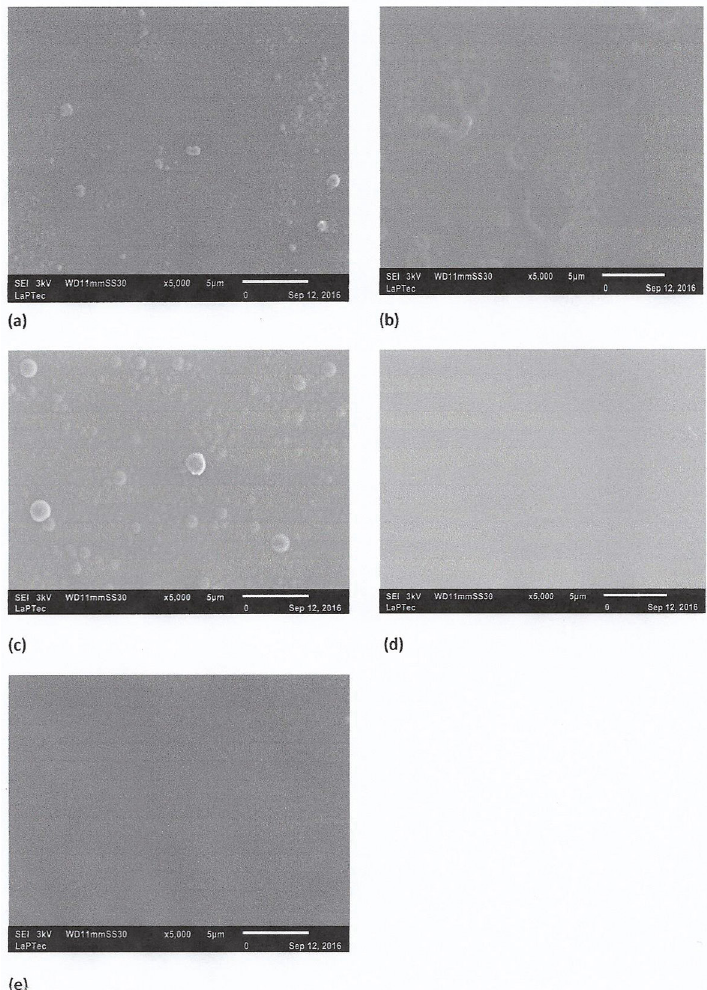
values of (a) 0%, Cl